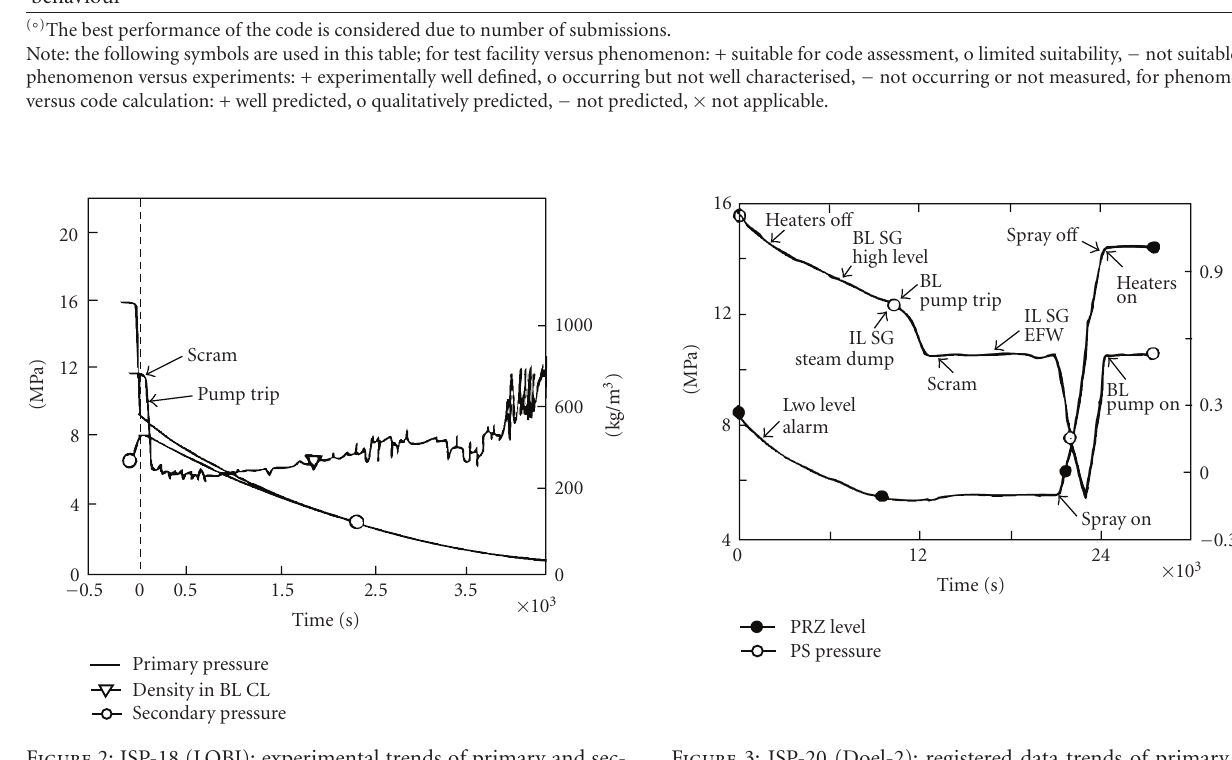
Figure 2: ISP-18 (LOBI): experimental trends of primary and sec- ondary side pressures and broken loop cold leg density.